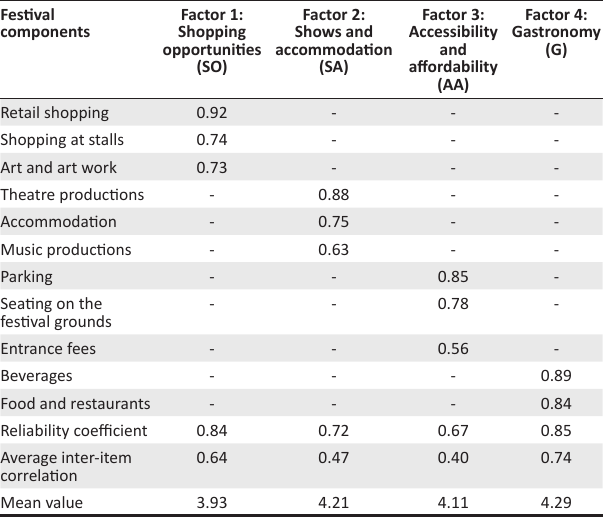
TABLE 1: Results from the factor analysis on visitors’ satisfaction with ‘festivalscapes’. Festival